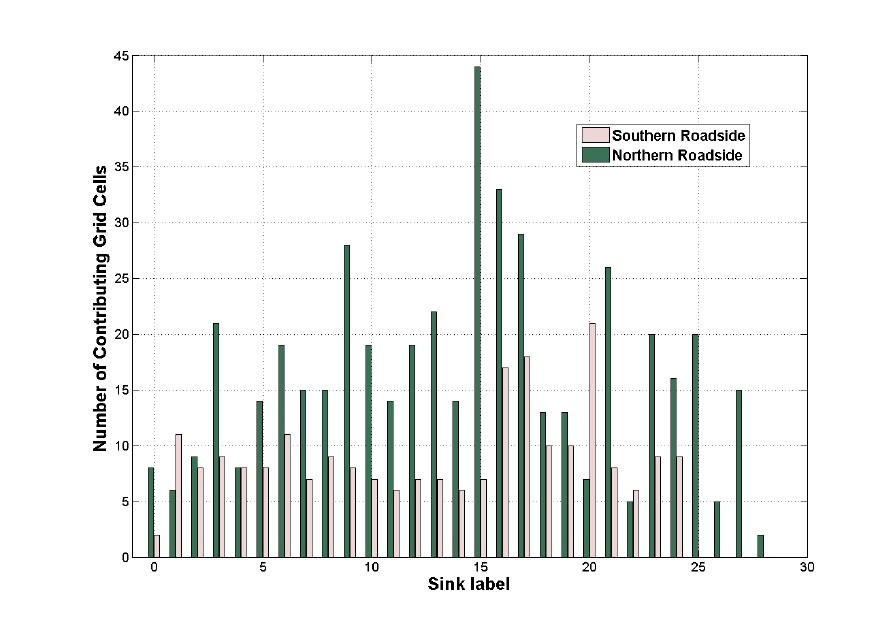
Figure 10: Count of catchment area cells for both